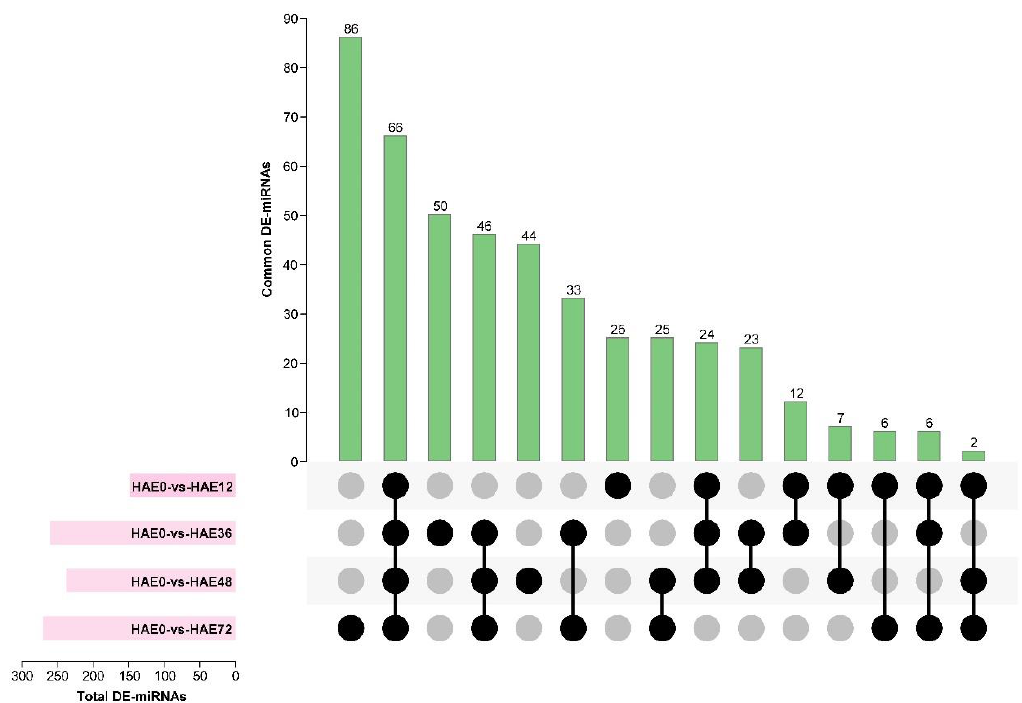
Figure 2. The number of differentially expressed (DE) microRNAs in dark-pretreated micro-shoot cuttings of tetraploid R. pseudoacacia L. during IBA-dependent AR formation in seven comparison group libraries (HAE0-vs-HAE12, HAE0-vs-HAE36, HAE0-vs-HAE48, HAE0-vs-HAE72, HAE12- vs-HAE36, HAE36-vs-HAE48, and HAE48-vs-HAE72). ( a ) Total upregulated and downregulated DE miRNAs expressed in seven comparison group libraries. ( b ) Venn diagrams showing the num- ber of the differentially expressed miRNAs in the seven comparison group libraries. ( c ) Heatmap showing the fold changes of miRNAs in comparison group libraries.